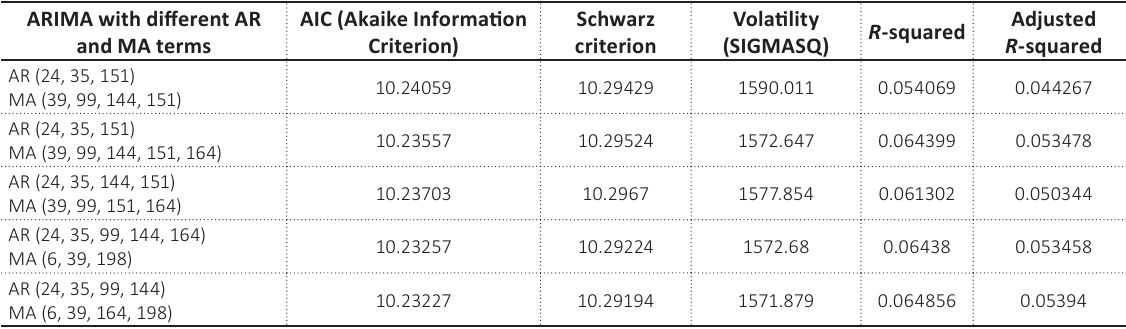
Table 8. Results of best 5 adjusted ARIMA models for Dr. Reddy’s Laboratories